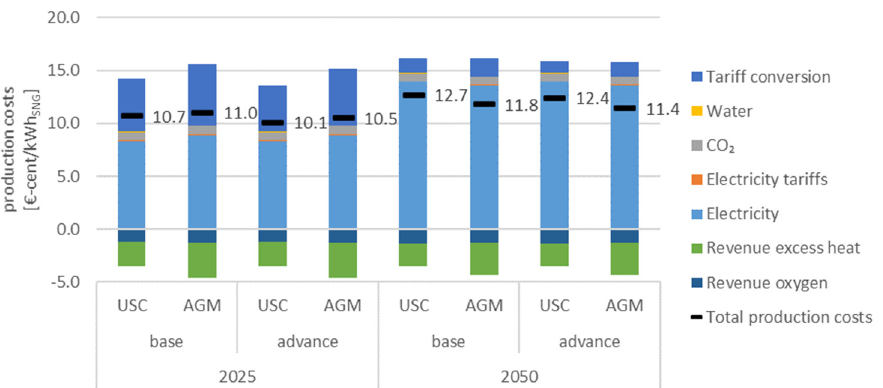
Figure 13. Geomethane production costs with a 100,000 Nm³/h USC plant and a comparable AGM.